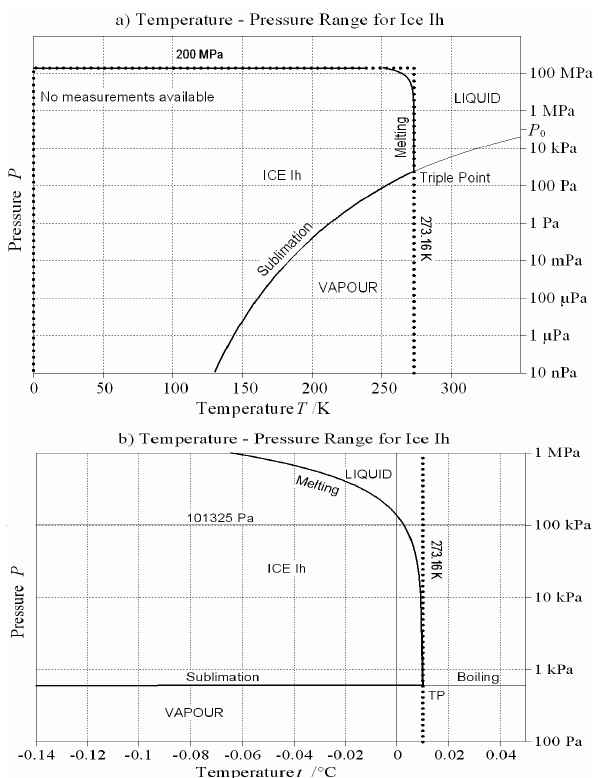
Fig. 5.2: Panel a) Range of validity (solid bold curves) of the Gibbs function of ice Ih according to IAPWS-06 and Feistel and Wagner (2007). The heavy dotted curves indicate the boundaries beyond which the library code returns an ErrorReturn value to indicate that the validity range has been violated. No warning is provided when ice_g_si is accessed outside of the solid bold lines but still within the heavy dotted lines. Panel b) An expanded view showing the region very near the triple point, TP. Note that the melting temperature of 273.152 519 K is actually significantly reduced from 273.16 K at the standard atmospheric pressure of 101325 Pa. (Panel a is adapted from Fig. 2 of Part 1.)